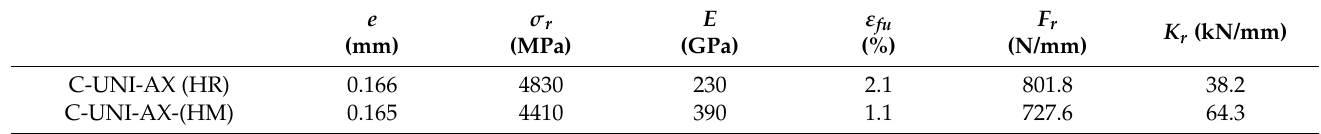
Table 3. Geometrical and mechanical characteristics of the fabrics